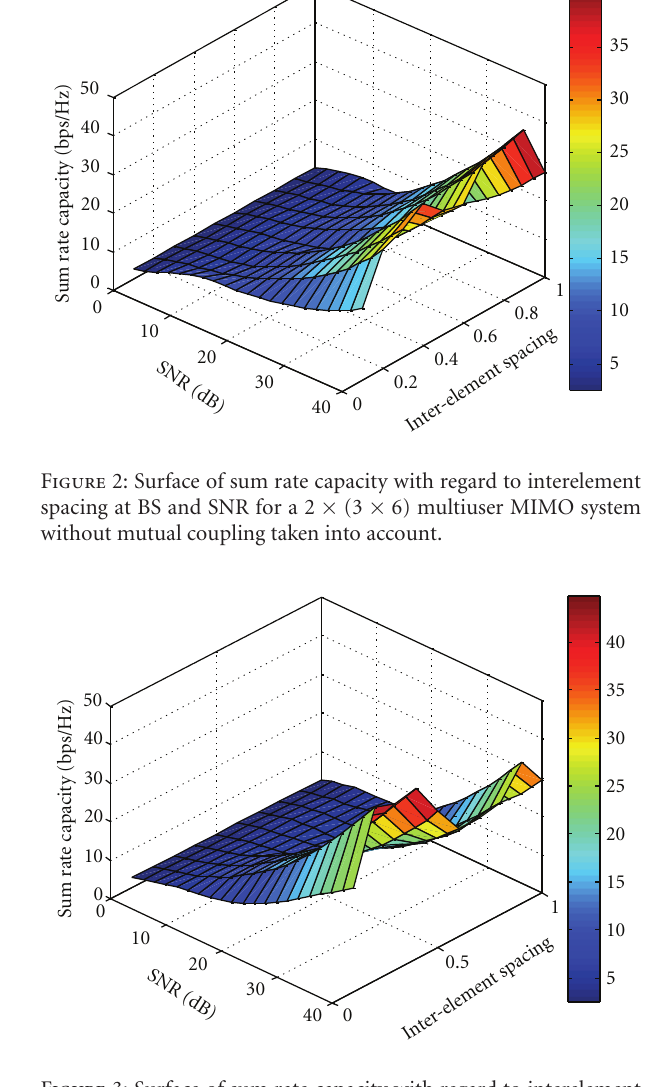
Figure 3: Surface of sum rate capacity with regard to interelement spacing at BS and SNR for a 2 × (3 × 6) multiuser MIMO system with mutual coupling taken into